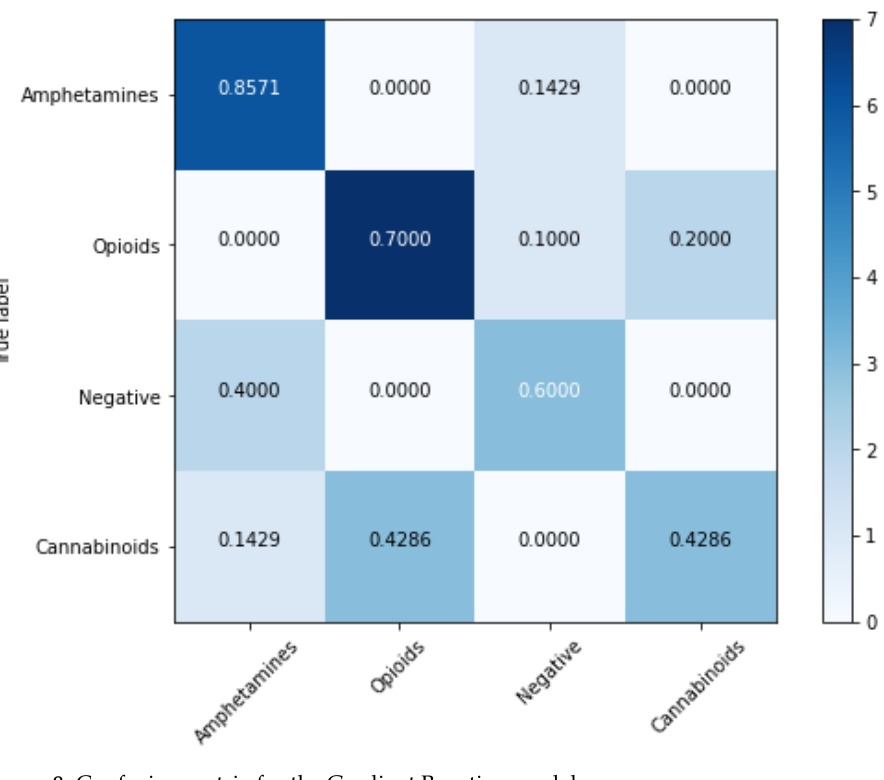
Figure 7. Confusion matrix for the Random Forest model.